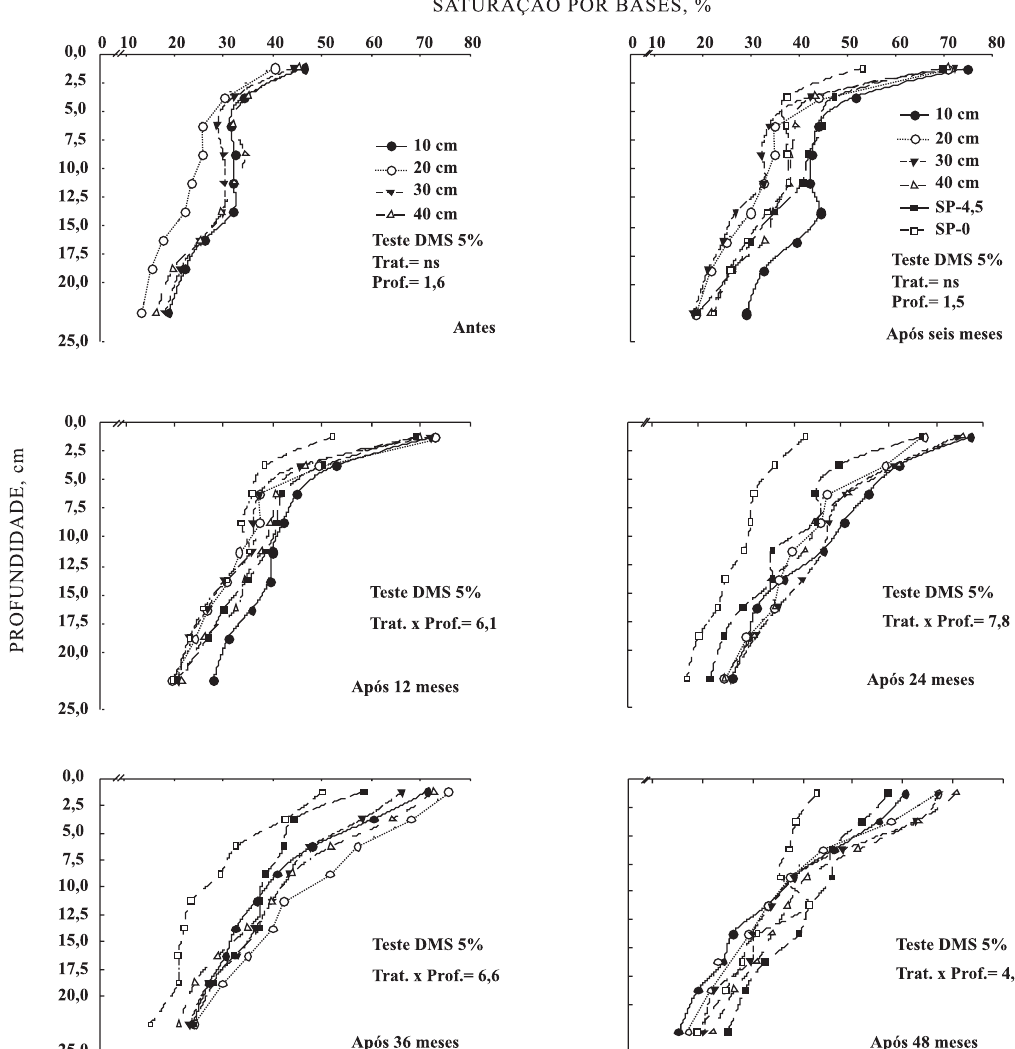
Figura 4. Valores de saturação por bases em diferentes épocas da aplicação superficial de calcário em Latossolo Vermelho, sob sistema plantio direto e integração lavoura-pecuária, com diferentes pressões de pastejo no inverno (ns: não